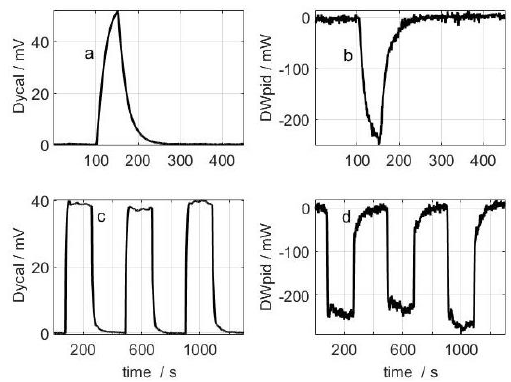
Figure 10. Measurement performed on the calibration base: ( a ) calorimetric signal; and ( b ) power dissipated in the thermostat. Measurement performed on the large resistor placed on the laboratory workbench: ( c ) calorimetric signal; and ( d ) power dissipated in the thermostat. The baseline was corrected for the four curves displayed.